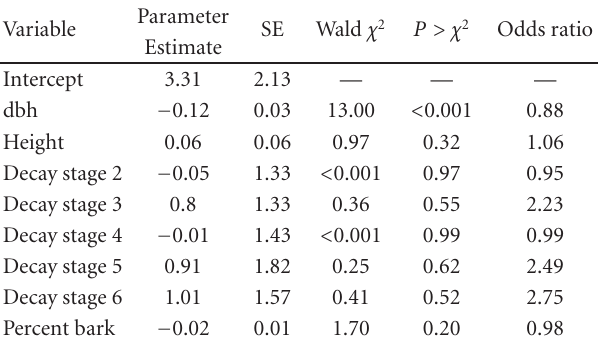
Table 7: Parameter summary of the best supported model compar- ing Myotis septentrionalis sassafras day-roosts to day-roosts of other species on the Fort Knox military reservation in Hardin, Bullitt and Meade counties, Kentucky, USA,